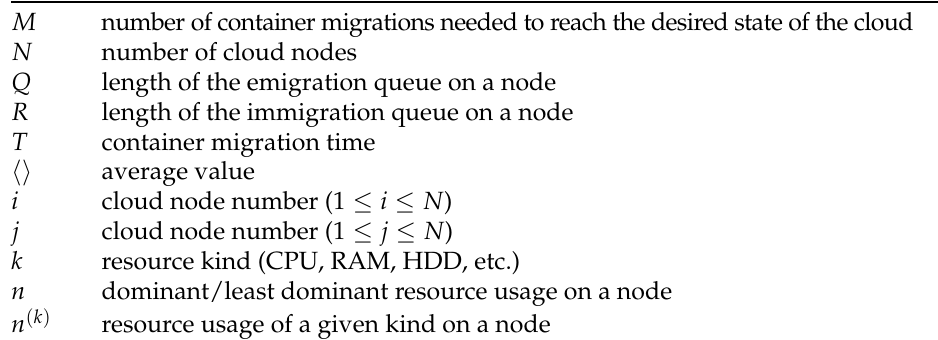
Table A1. Notations used in this